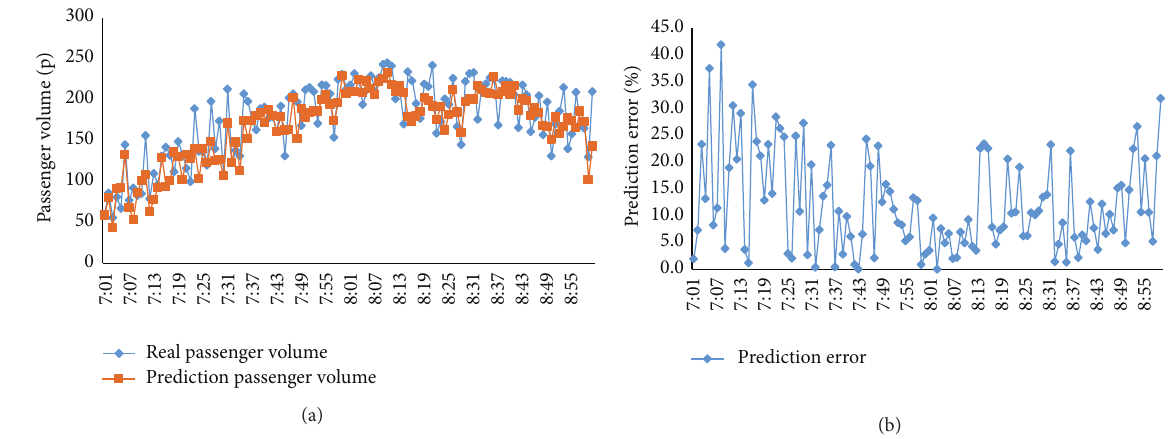
Figure 6: Forecasting result for each 1 minute in morning peak hour using nonparametric regression.